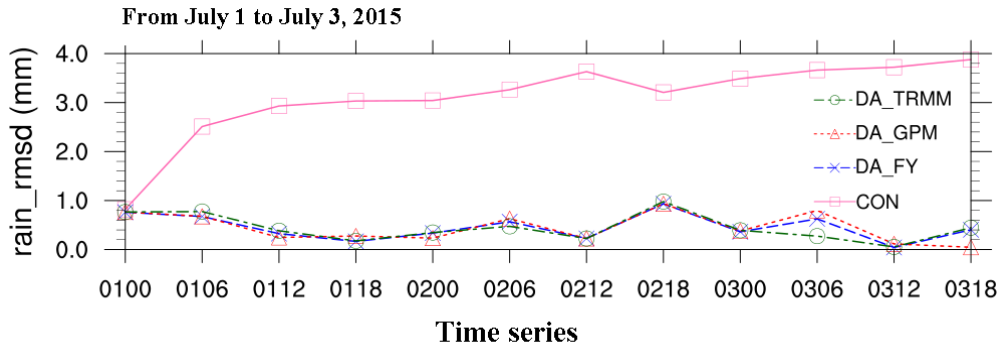
Figure 14. Six-hour accumulated precipitation root mean squared error between precipitation simulation and HiWATER station observation from 1 July to 4 July 2015 at the second domain.